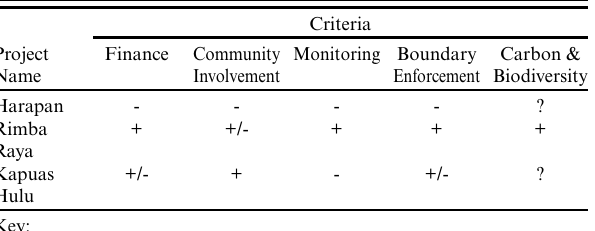
Table 1 . Criteria for achieving effective outcomes for REDD+ projects in